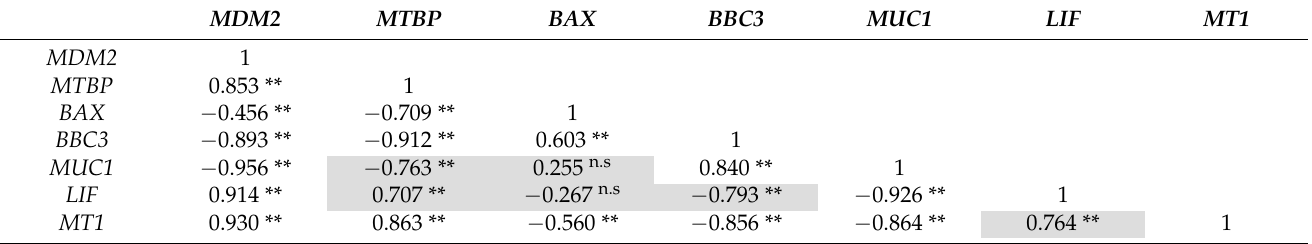
Table 2. Standard partial correlations 1 of genes expressed in uterine luminal cells collected at day 16 after insemination from pregnant, pregnant with embryo loss, and nonpregnant lactating dairy cows. MDM2